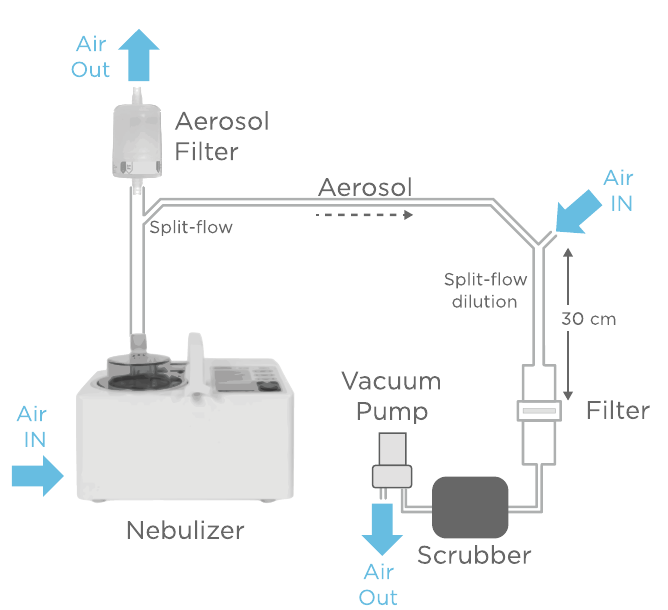
Figure 2. The aerosol generating system was adapted to disperse inactivated virus onto filters. Particles containing inactivated virus diluted in DMEM were generated using an OMRON nebulizer, mixed with air and drawn onto an electrostatic filter by a vacuum